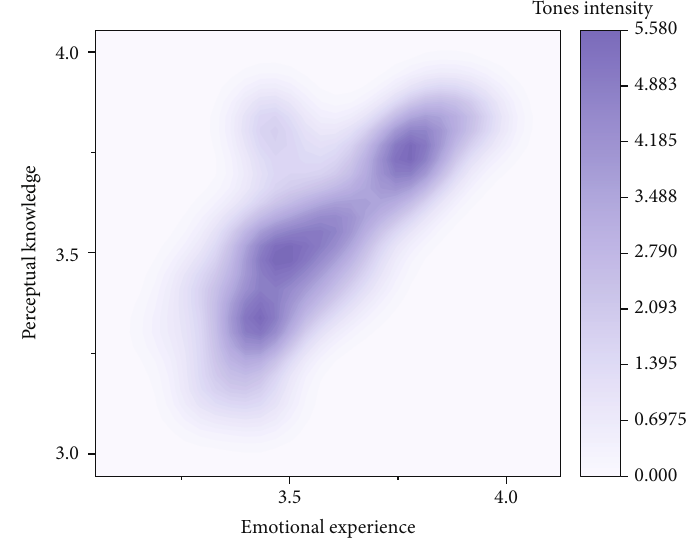
Figure 6: Change in the proportion of perceptual knowledge and emotional